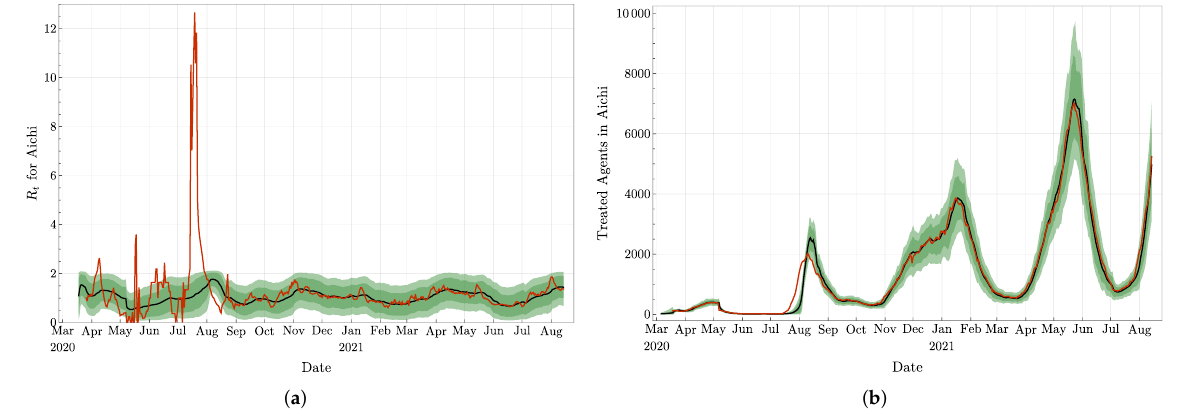
Figure 14. ( a ) Effective reproduction number for Aichi ( a ): The black curve and the green confidence intervals are from our approach, and the red curve is borrowed from [42]. ( b ) Observation value of T (in red) and analyzed values with mean value (in black) and 68%, resp. 90%, confidence interval for